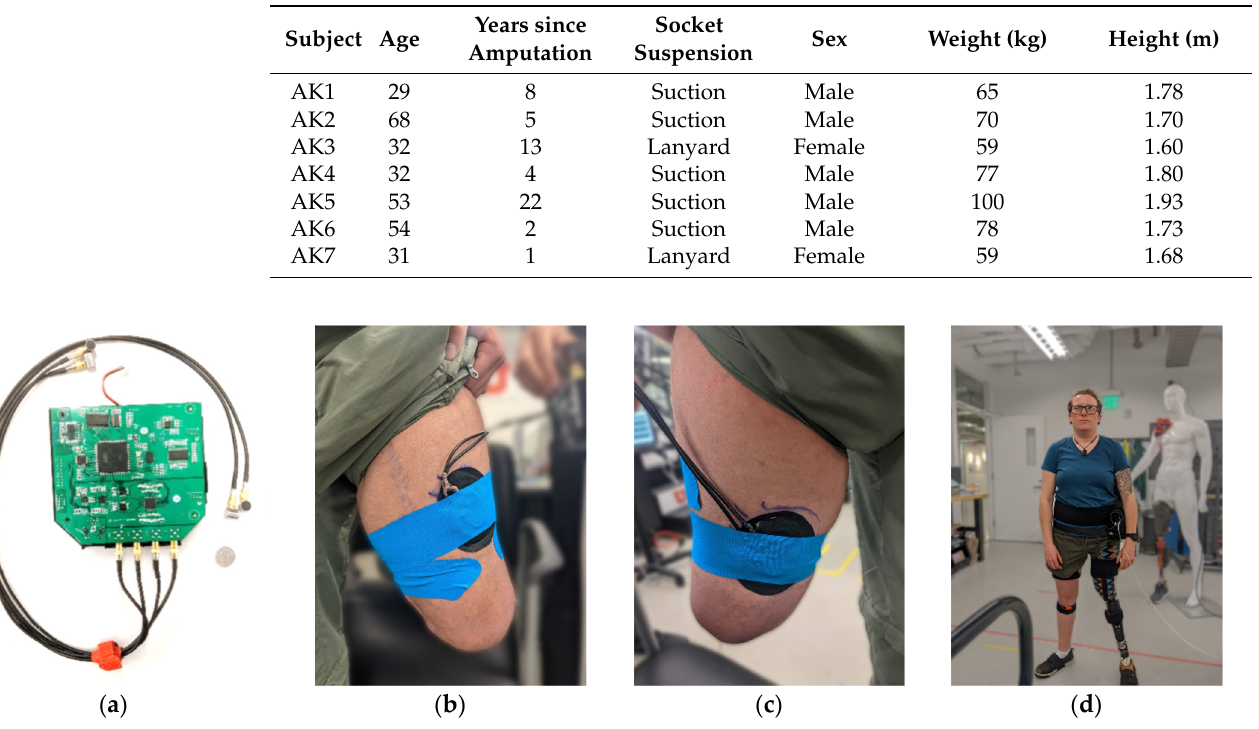
Figure 1. Sensor placement: ( a ) A-mode ultrasound system, with dime for scale. ( b ) Anterior US transducers placement. ( c ) Posterior US transducers placement. ( d ) Subject equipped with US system and IMU sensors.